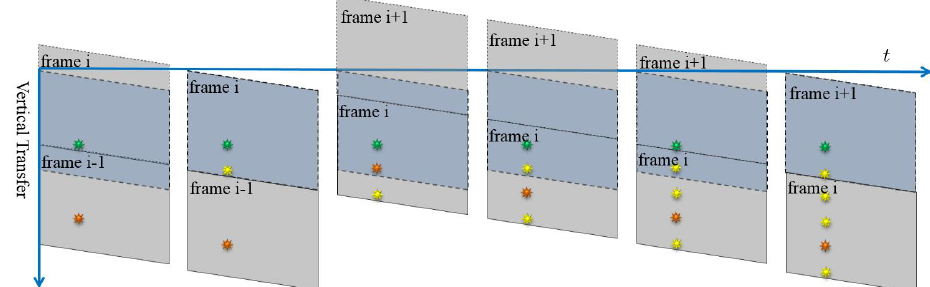
Figure 5. The process of the smear generation of a strobe light source for frame i. The yellow sun symbol denotes the smear. In the whole timeline to generate frame i, only the moments when the strobe turns on are shown.